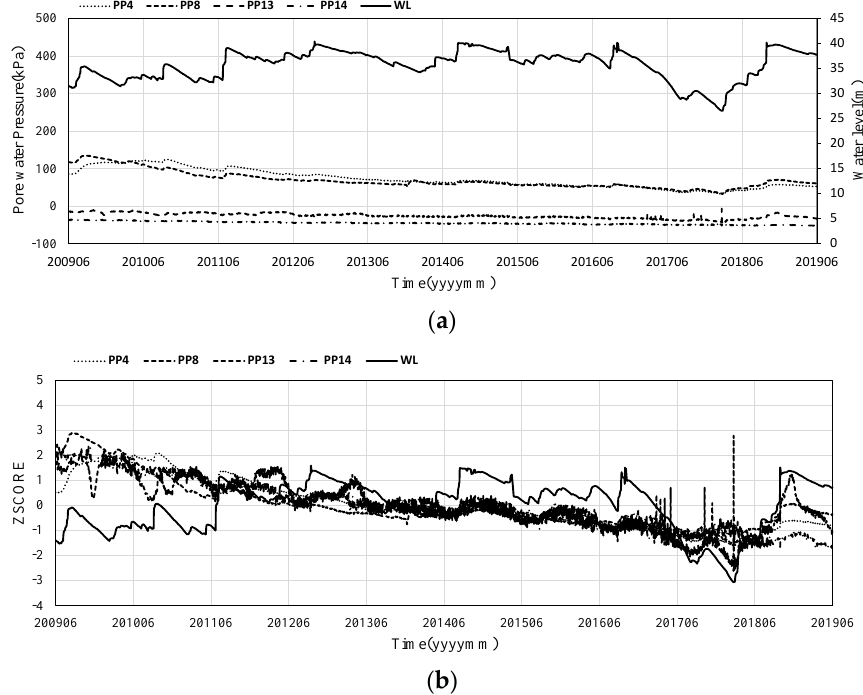
Figure 9. Relationships between water level and porewater pressure for group B: ( a ) comparisons with water level and Group B; ( b ) z-score for Group B with water level.